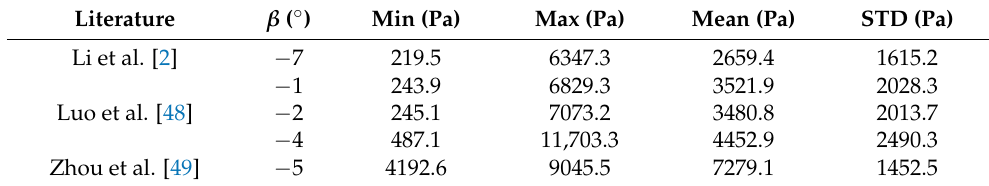
Table 2. Details of the entire